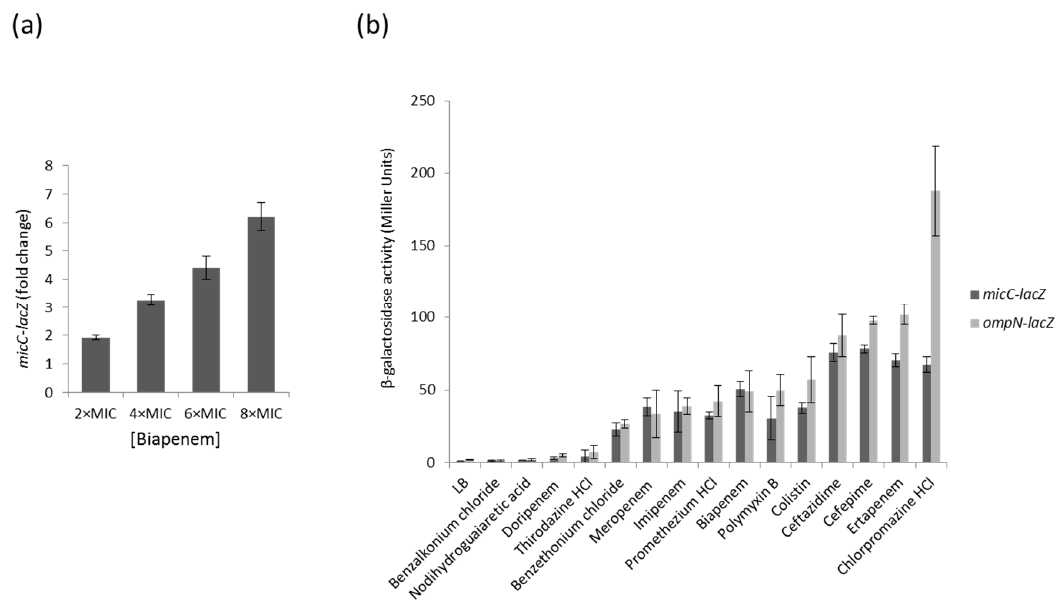
Figure 1. ( a ) Dose dependent micC–lacZ activity in presence of increasing concentrations of biapenem (MIC of 0.32 µg/mL); ( b ) β -galactosidase activity of the micC- and ompN-lacZ fusions in the presence of selected compounds. Values are means from three independent determinations, and standard deviation is represented.